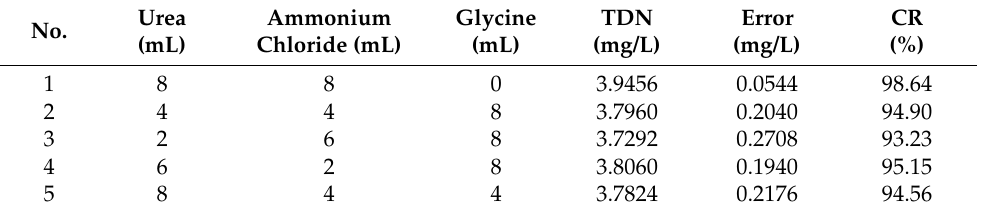
Table 3. Experimental scheme and results of the digestion of total dissolved